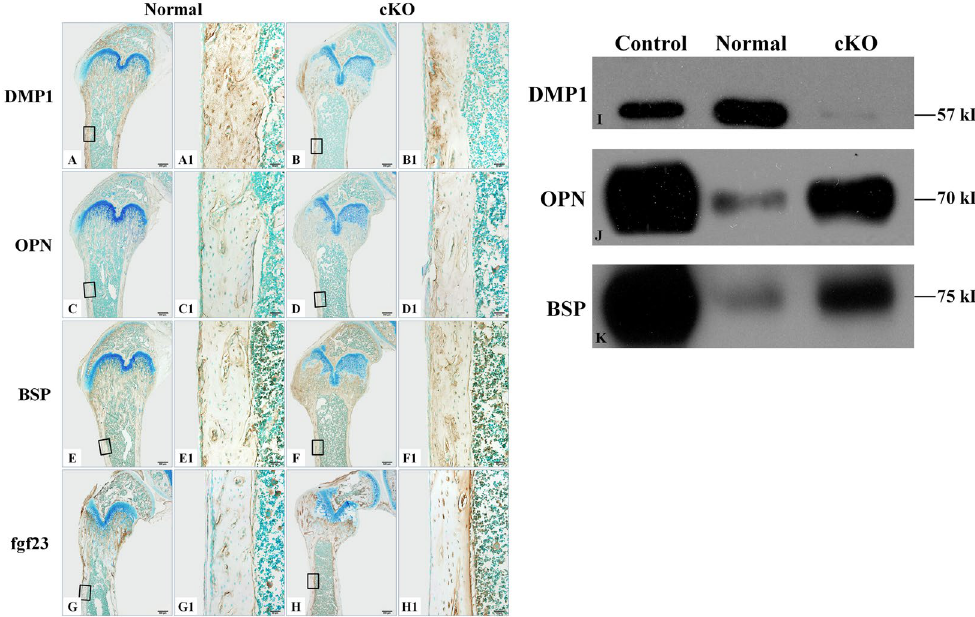
Figure 5. Assessment of ECM protein levels in the cKO mice versus normal mice. ( A – H1 ) immunohistochemistry for DMP1 ( A–B1 ), OPN ( C–D1 ), BSP ( E–F1 ) and FGF23 ( G–H1 ) in the femurs of 4-week-old mice; ( A1 , B1 , C1 , D1 , E1 , F1 , G1 and H1 ) were the higher magnification views of the box areas in A,B,C,D,E,F,G and H , respectively. ( A , B , C , D , E , F , G and H ) were from consecutive sections. Bars in ( A , B , C , D , E , F , G and H ): 500 µ m; bars in ( A1 , B1 , C1 , D1 , E1 , F1 , G1 and H1 ) 50 µ m. ( I–K ) Western immunoblotting analyses for DMP1, OPN and BSP in the protein extracts from the long bone of 12-week- old mice; equal amounts of total proteins from the normal and cKO groups were loaded for detecting each of the proteins. The cortical bone of the cKO mice ( B , B1 ) contained many areas that lacked anti-DMP1 signals. Immunohistochemistry analyses showed that the levels of OPN, BSP and FGF23 were higher in the cortical bone of the cKO mice than in the normal mice ( C , C1 , D , D1 , E , E1 , F , F1 , G , G1 , H , H1 ). In the Western immunoblotting analyses, DMP1 band in the cKO group was weaker while that of OPN or BSP was stronger than in the normal mice ( I , J , K ). The samples in the control lanes were DMP1, OPN and BSP, respectively; these proteins were extracted and purified from the rat long bone 35 .